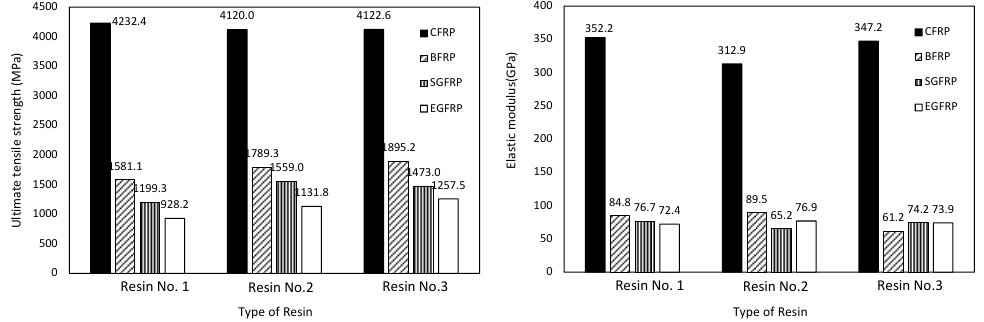
Figure 7. Tensile strength and elastic modulus of FRPs using different resin matrixes (without UV effect).